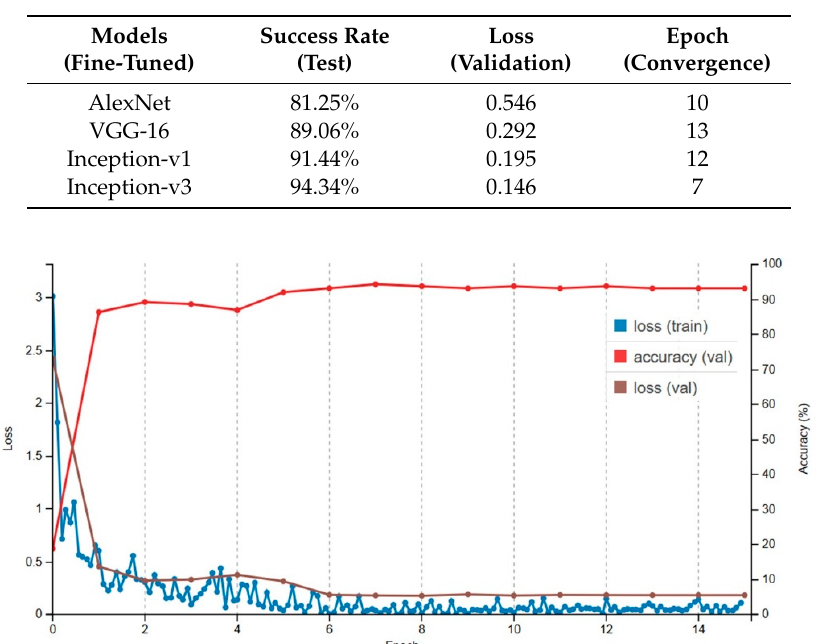
Table 5. Performance of various pre-trained CNNs fine-tuned on the dataset with data augmentation.